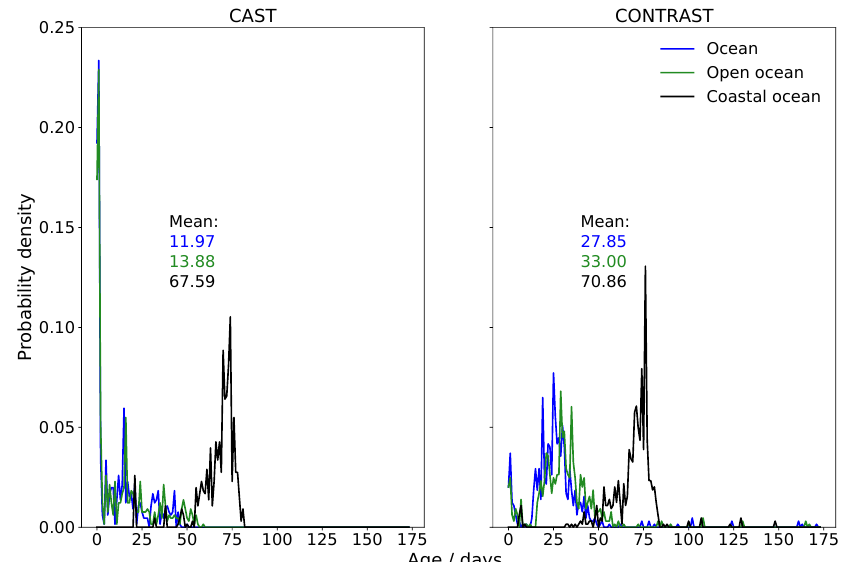
Figure 9. As Fig. 8 but sampled along CAST and CONTRAST flight tracks.